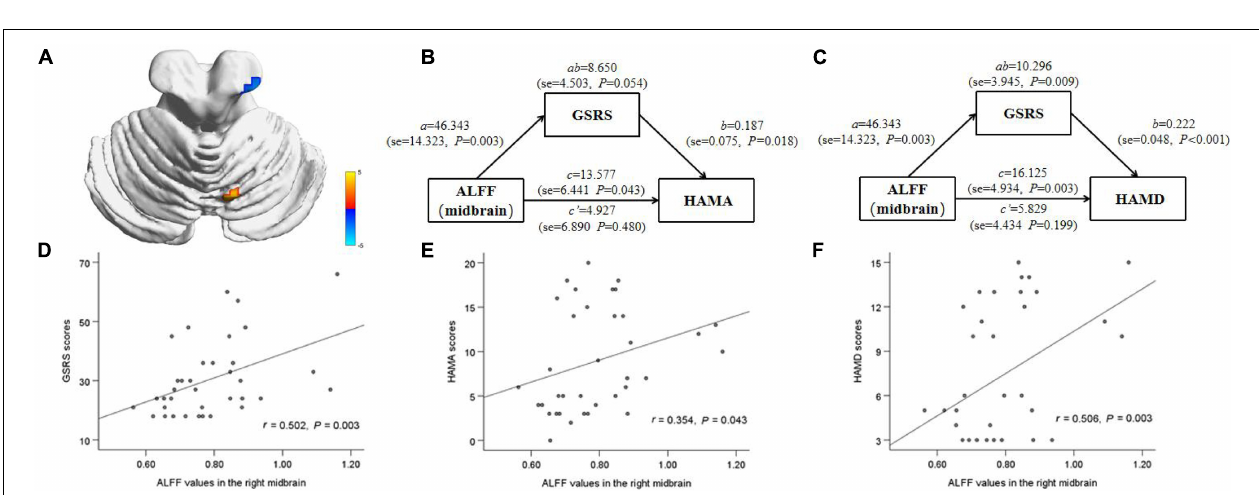
FIGURE 4 | Correlation and mediation analyses between ALFF value in the right midbrain and emotional symptoms. The area in blue color shows a reduction in ALFF (midbrain) in IBS-D patients compared to the healthy controls (A) . The gastrointestinal symptoms completely mediated the relationship between ALFF in the right midbrain and HAMA (critical statistical significance), HAMD scale (B,C) . The positive correlations were observed between ALFF value in right midbrain and gastrointestinal symptoms and HAMA, HAMD scale in IBS-D patients (D–F) . HAMD, Hamilton depressive scale; HAMA, Hamilton anxiety scale; GSRS, gastrointestinal symptoms rating